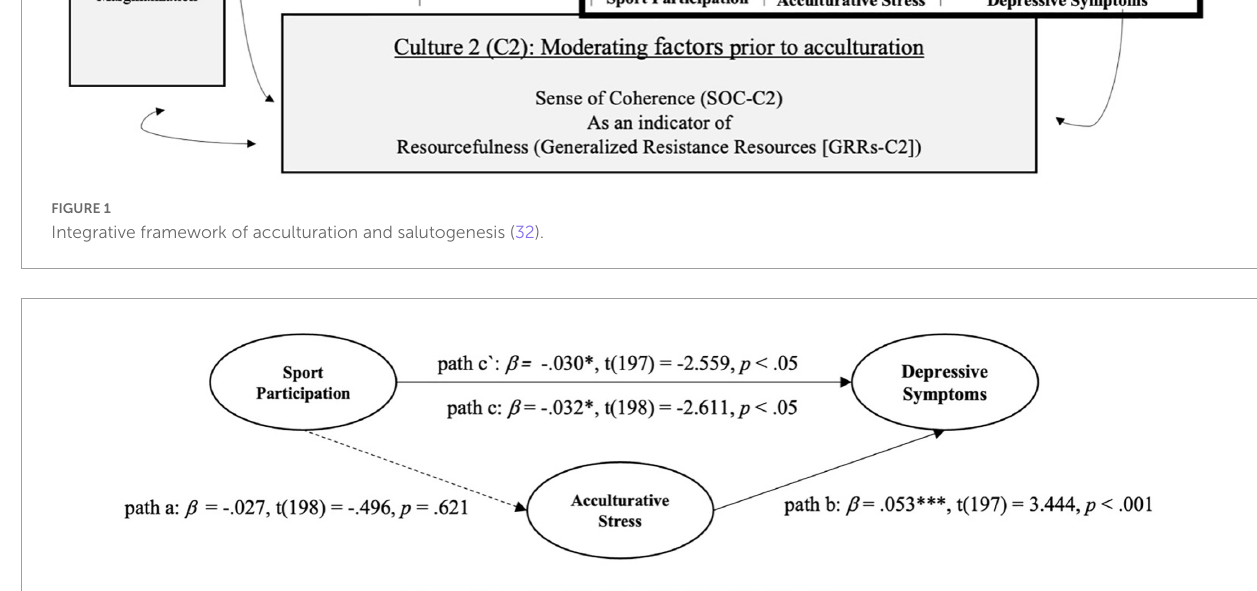
FIGURE2 Mediation analysis of acculturative stress (AS) on sport participation (SP) and depressive symptoms (DS). * p < 0.05, ** p < 0.01, *** p <